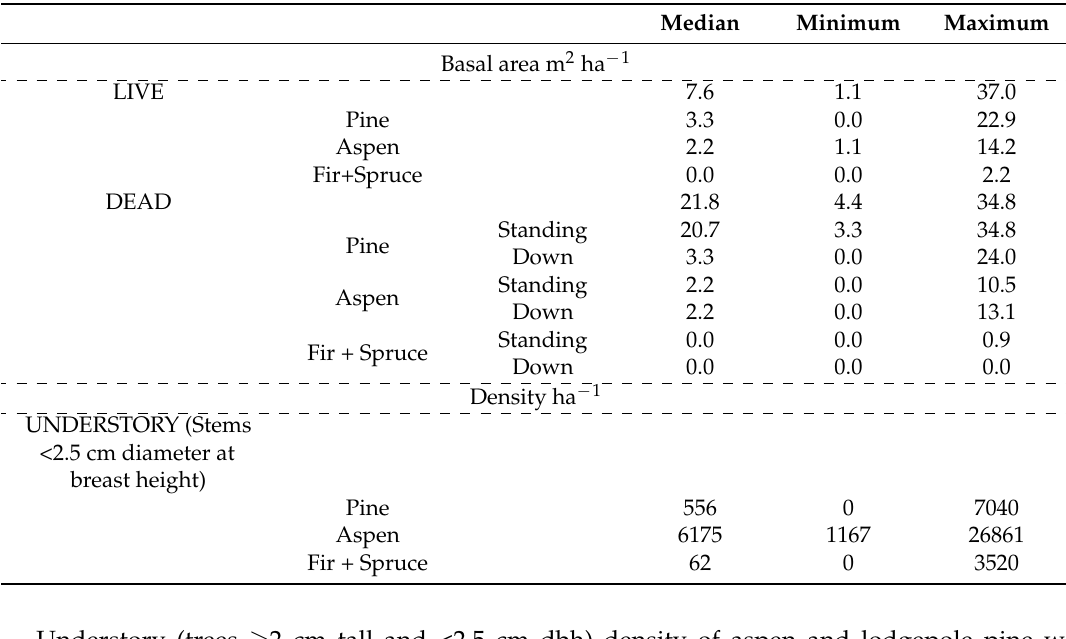
Table 1. Summary of basal area and understory tree density in sampled stands ( n = 33).